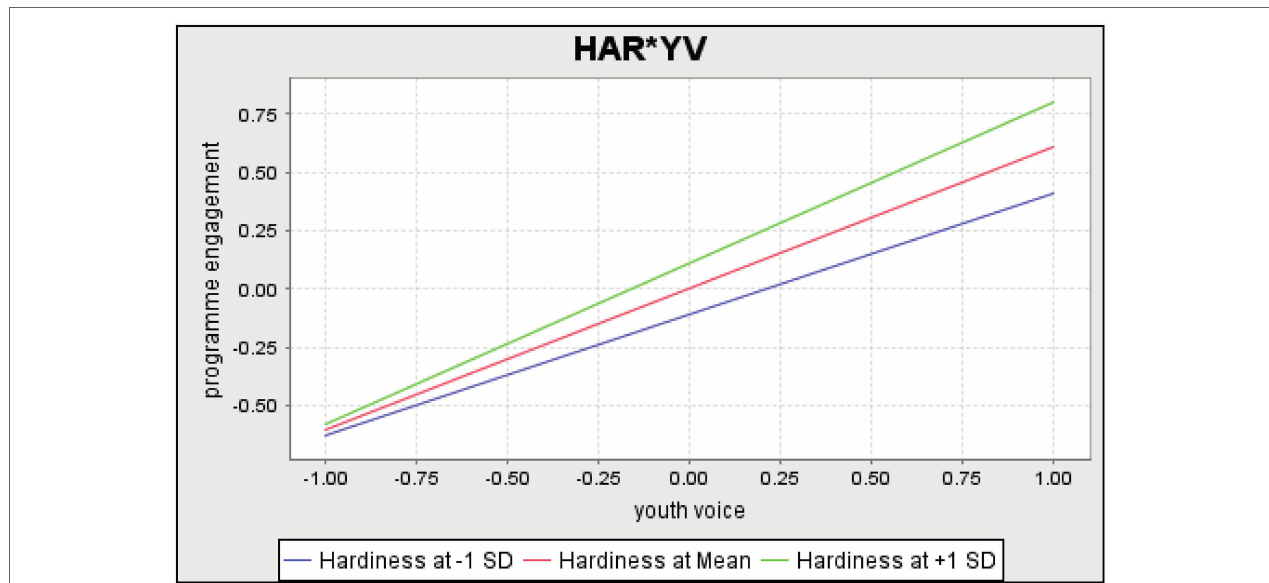
FIGURE 2 | Results of the moderating effect of hardiness on the relationship between youth voice and program